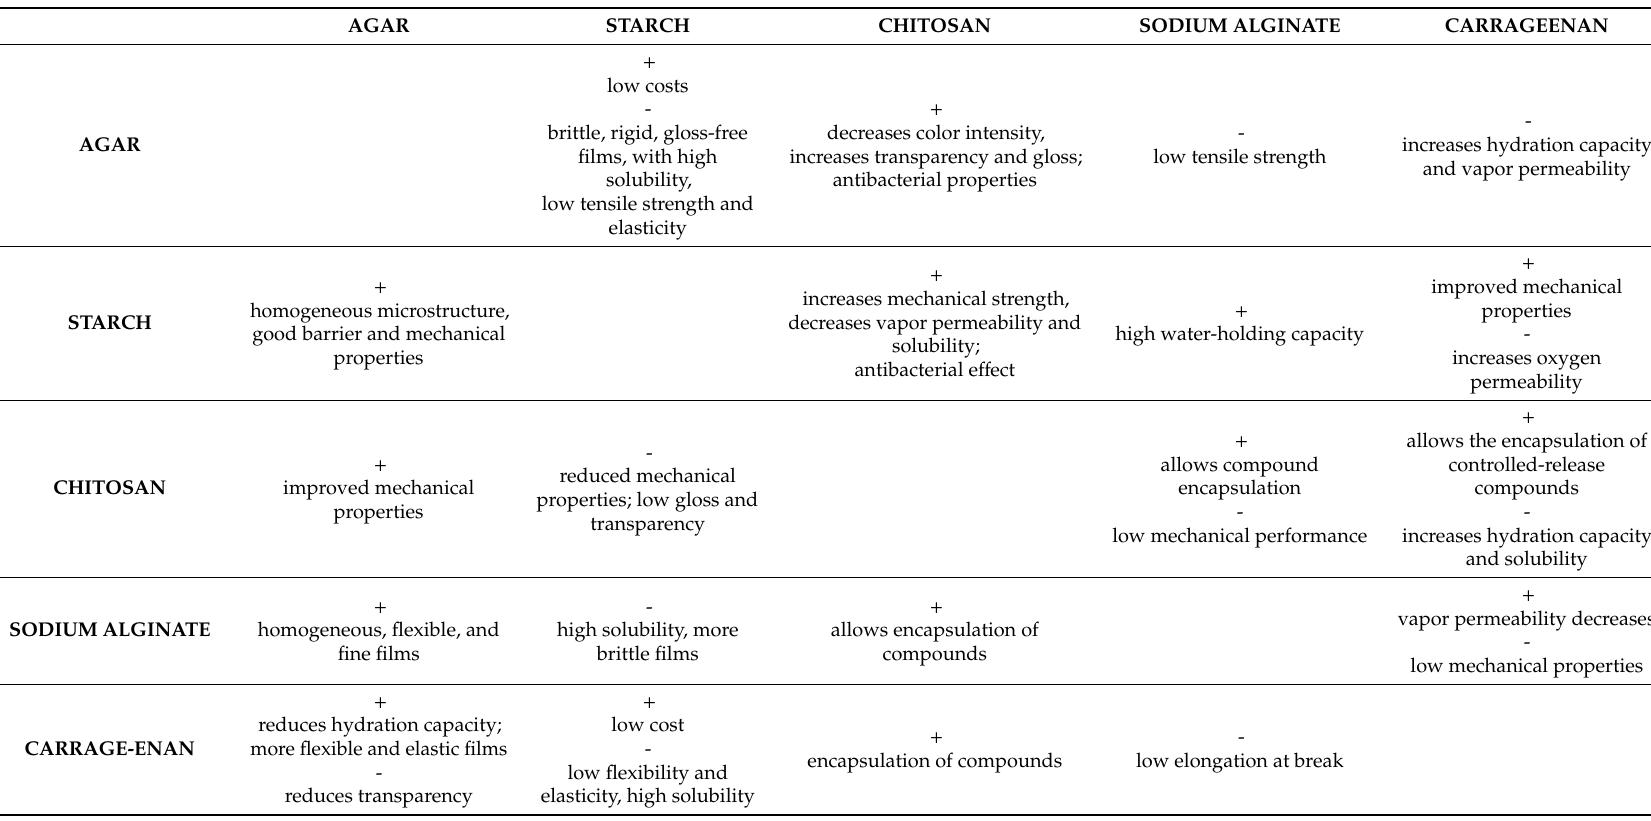
Table 1. Synergic characteristics of composite films obtained from